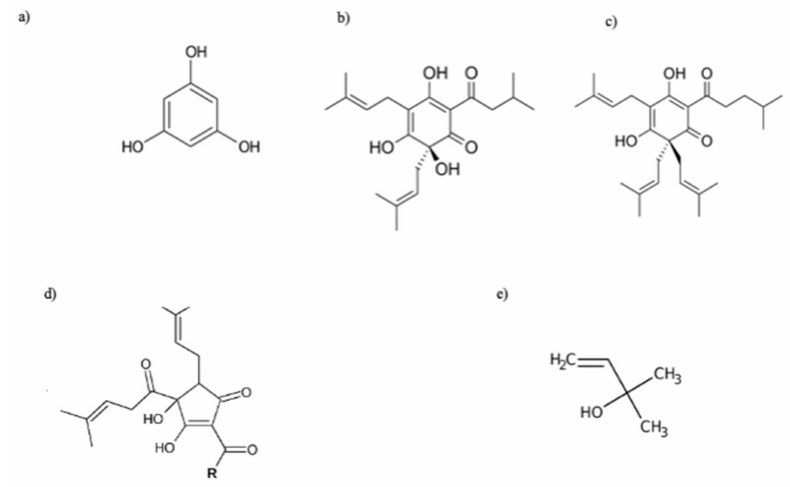
Figure 2. Chemical structure of ( a ) phloroglucinol (benzene-1,3,5-triol); ( b ) humulones; ( c ) lupulones; ( d ) iso- α -acids; ( e ) 2-methyl-3-buten-2-ol. Essential